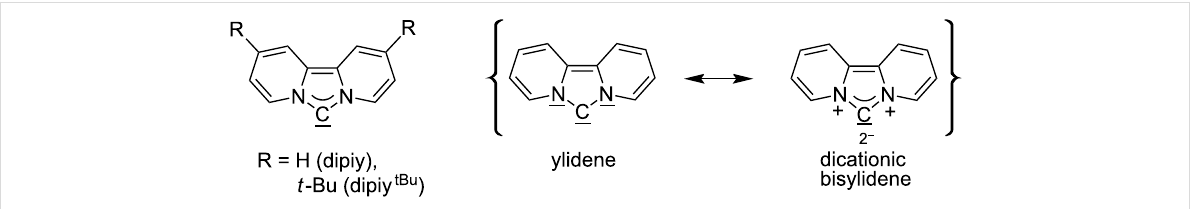
Figure 1: Left: resonance hybrid of the dipyrido carbenes dipiy and dipiy tBu . Right: two canonical forms of the dipyridocarbene according to Weiss and co-workers.